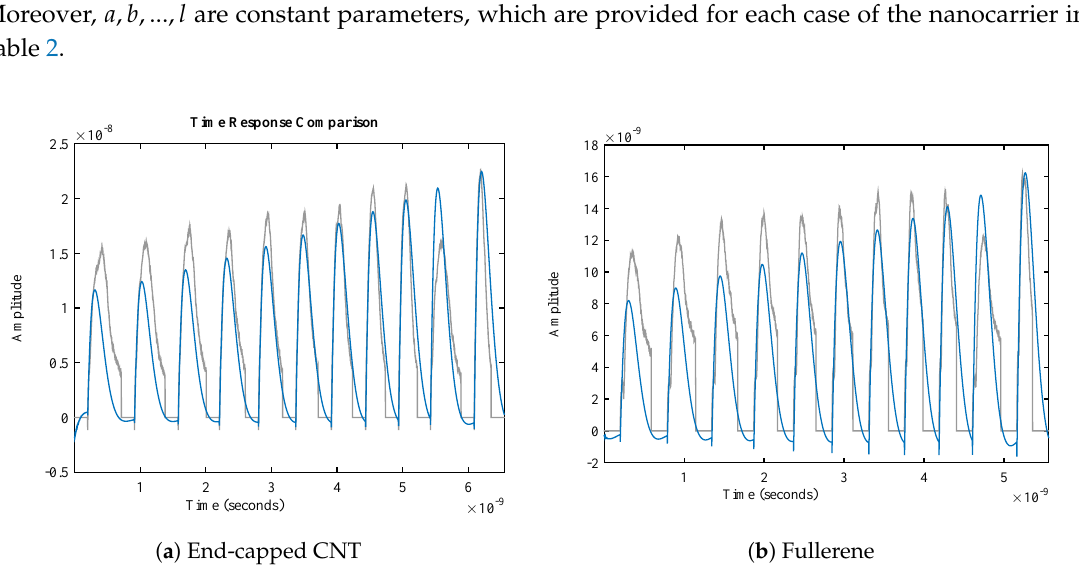
Figure 8. Best fitness for system identification. This figure shows the fitness quality of the data, which has been recorded from the molecular-level simulation. In this figure, diagrams of both the molecular level force and the mathematical model are